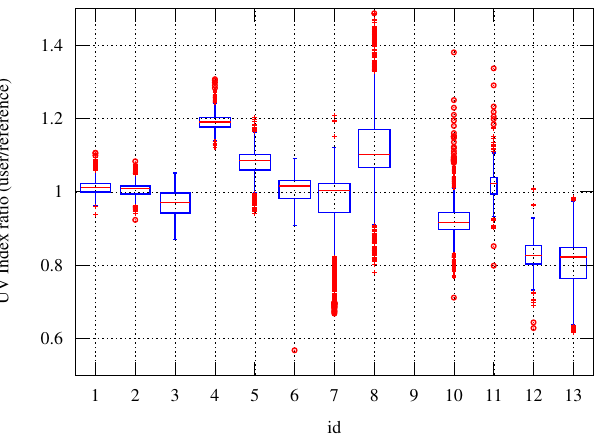
Fig. 10. Boxplot of UV-A irradiance ratios between each instru- ment and the reference, calculated under all sky conditions (both cloudy and clear